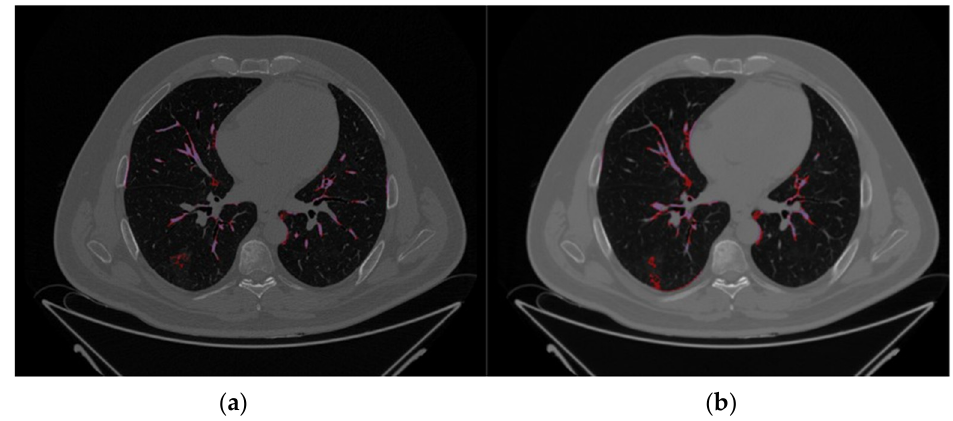
Figure 2. Axial CT images of the same representative patient using the same slice height, extracted from the validation databases, i.e., ( a ) Par-CT and ( b ) Med-CT. The purple and red zones are those identified by SOPHiA DDM as COVID-19 damage (hazy) and high density (Vascular tree), respectively.